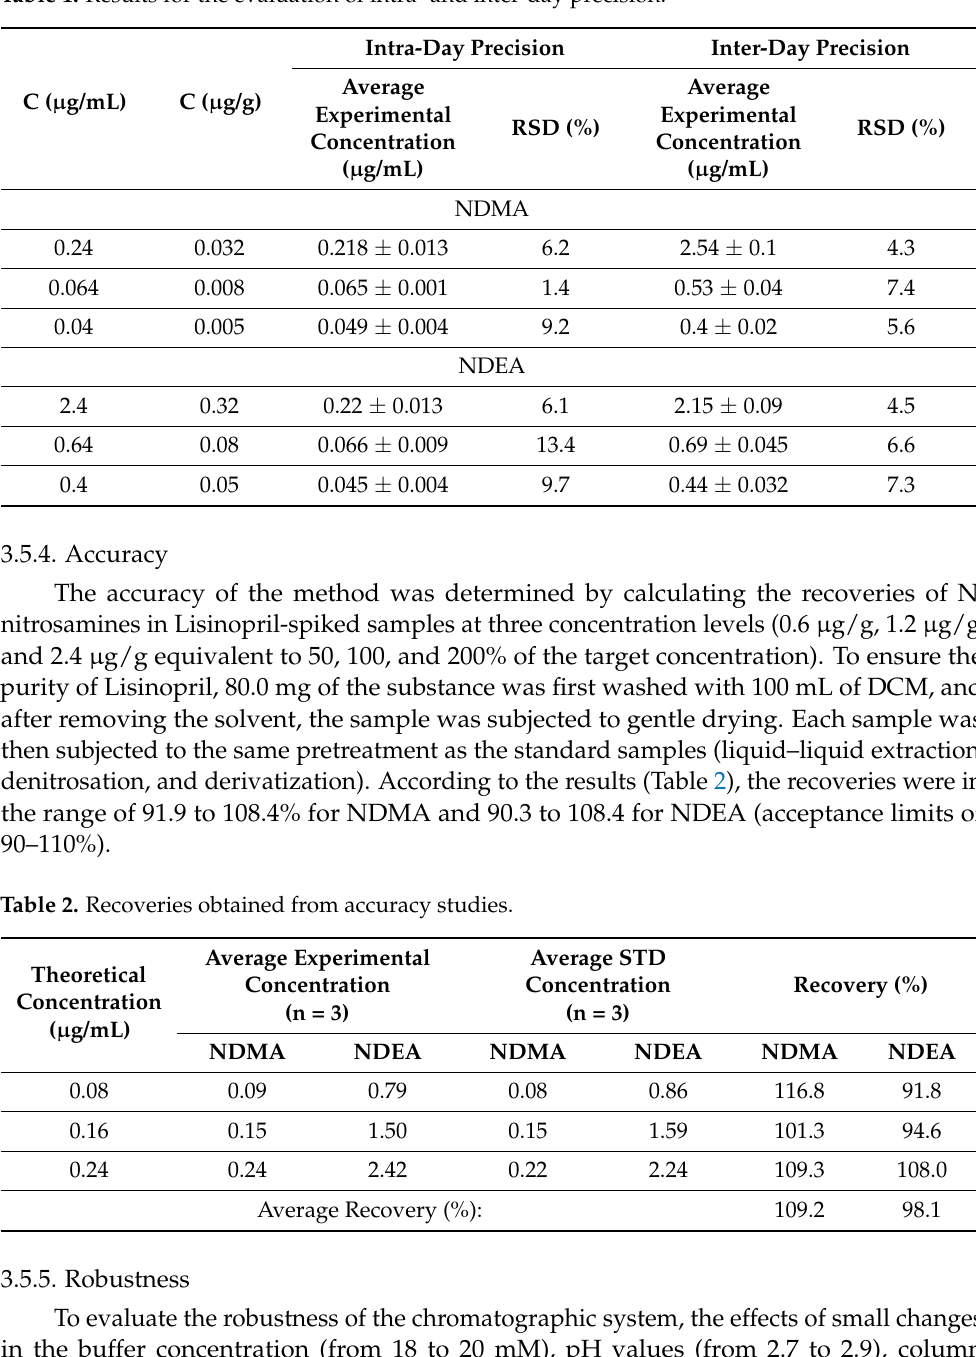
Table 1. Results for the evaluation of intra- and inter-day precision.